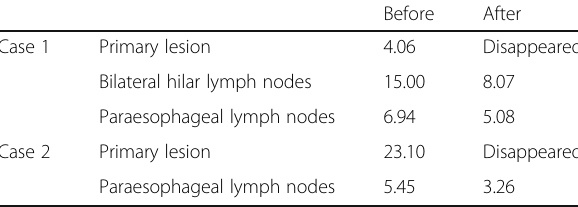
Table 1 Comparison of the SUV max before and after